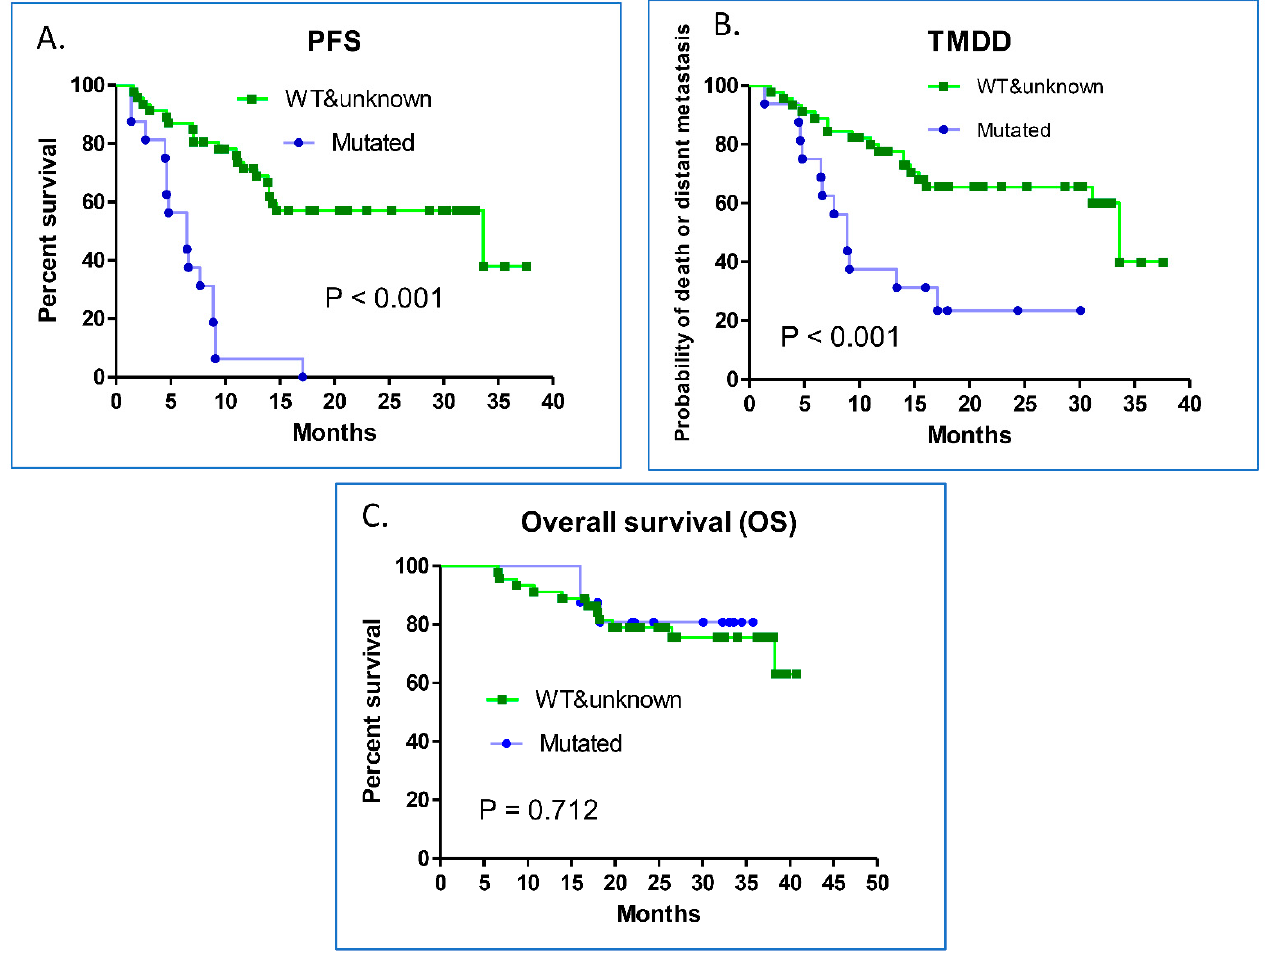
Figure 3. Kaplan–Meier survival curves of PFS, TMDD, and OS. Between the EGFR-mutated, and wild-type and unknown patients, ( A ) the median post-CCRT PFS was 6.50 months for the EGFR-mutated patients and 33.63 months for the EGFR wild-type and unknown patients (HR = 10.47; 95% CI, 4.55–24.07; p < 0.001); ( B ) the median post-CCRT TMDD of the EGFR-mutated patients was 8.9 months and 33.63 months for the EGFR wild-type and unknown patients (HR = 5.13; 95% CI, 1.96–13.44; p < 0.001); and ( C ) no statistically significant difference was found in the median OS between the EGFR-mutated, and wild-type and unknown groups. Table 4. Metastatic sites and subsequent systemic therapy following durvalumab in patients with progressive metastasis.